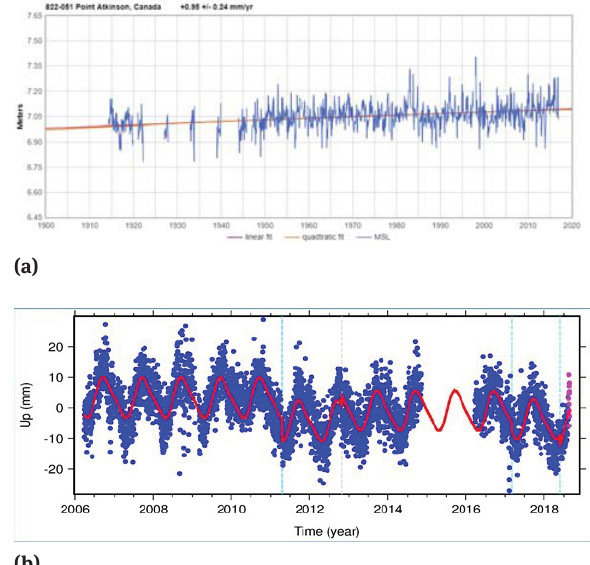
Figure 8: (a) MSL data for Point Atkinson, Canada. Image repro- duced modified after [4]. (b) GNSS time series for P440. Image re- produced modified after